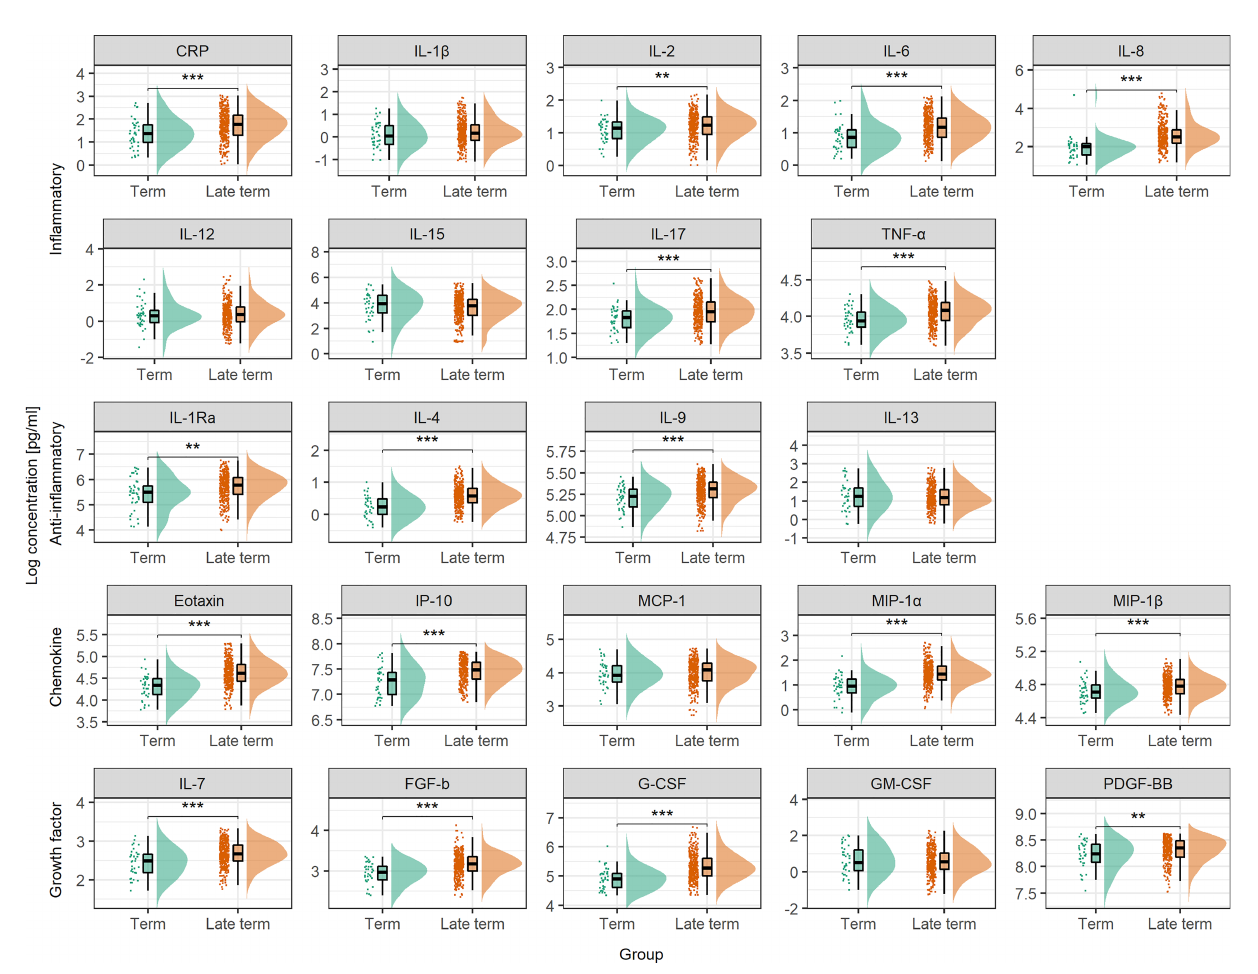
FIGURE 2 | Serum cytokine concentration at term and in late term. Serum cytokine concentrations are compared between term samples taken between week 37 +0 and 40 +3 of pregnancy ( n = 44) and late term samples taken at approximately week 41 +2 ( n = 396). Concentrations are shown as individual measurements, median and quantiles as box plot, and as distribution. To enhance readability, percentiles below 2.5 and above 97.5 are not shown. Statistical signi fi cance from Mann- Whitney ’ s U test. CRP is measured in µg/mL, cytokines in pg/mL. ** P < 0.01, *** P <